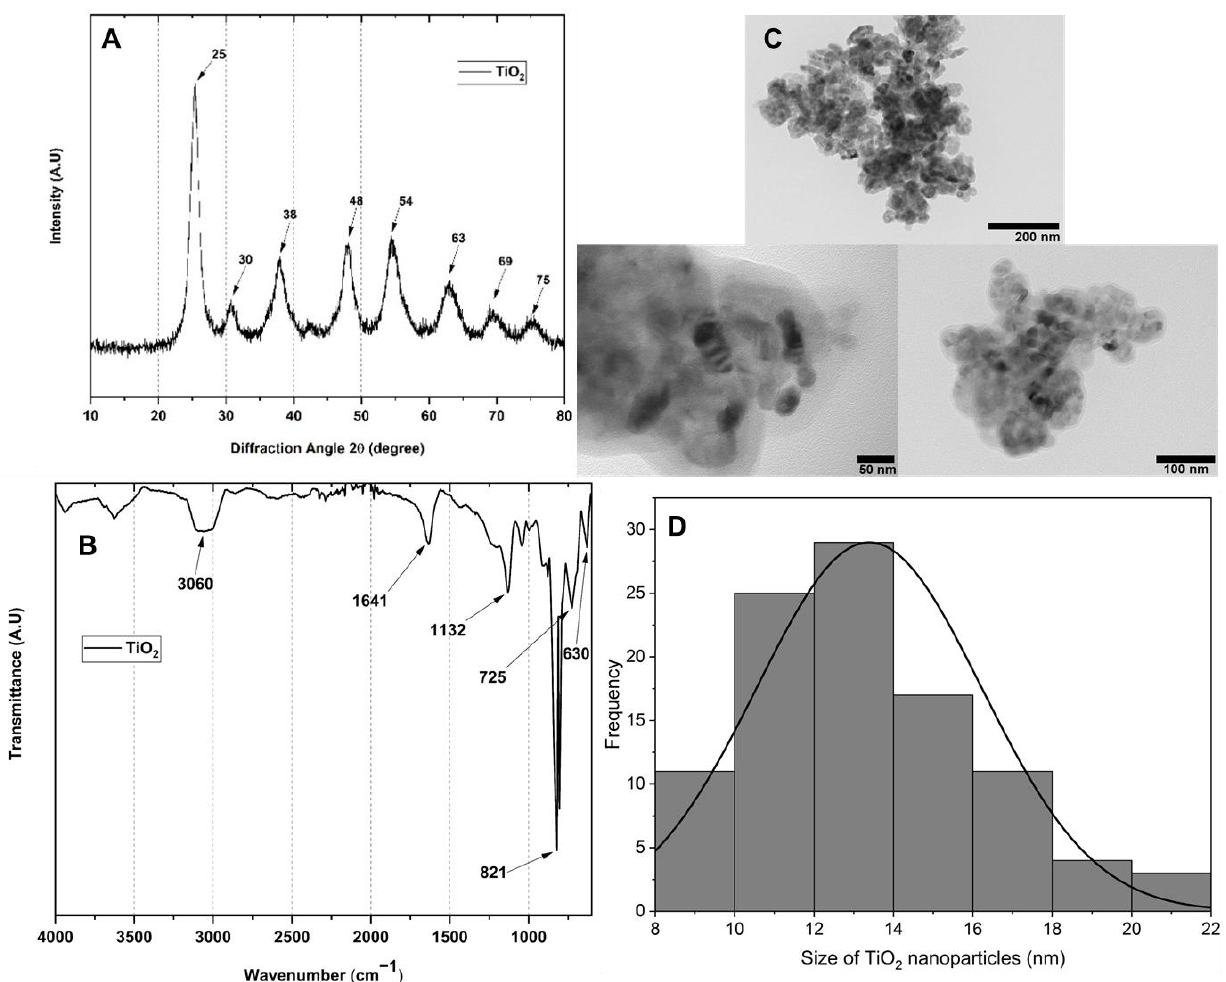
Figure 1. Characterization of TiO 2 nanoparticles: ( A ) XRD ( B ) FTIR ( C ) TEM, and ( D ) histogram of the TEM nanoparticle.